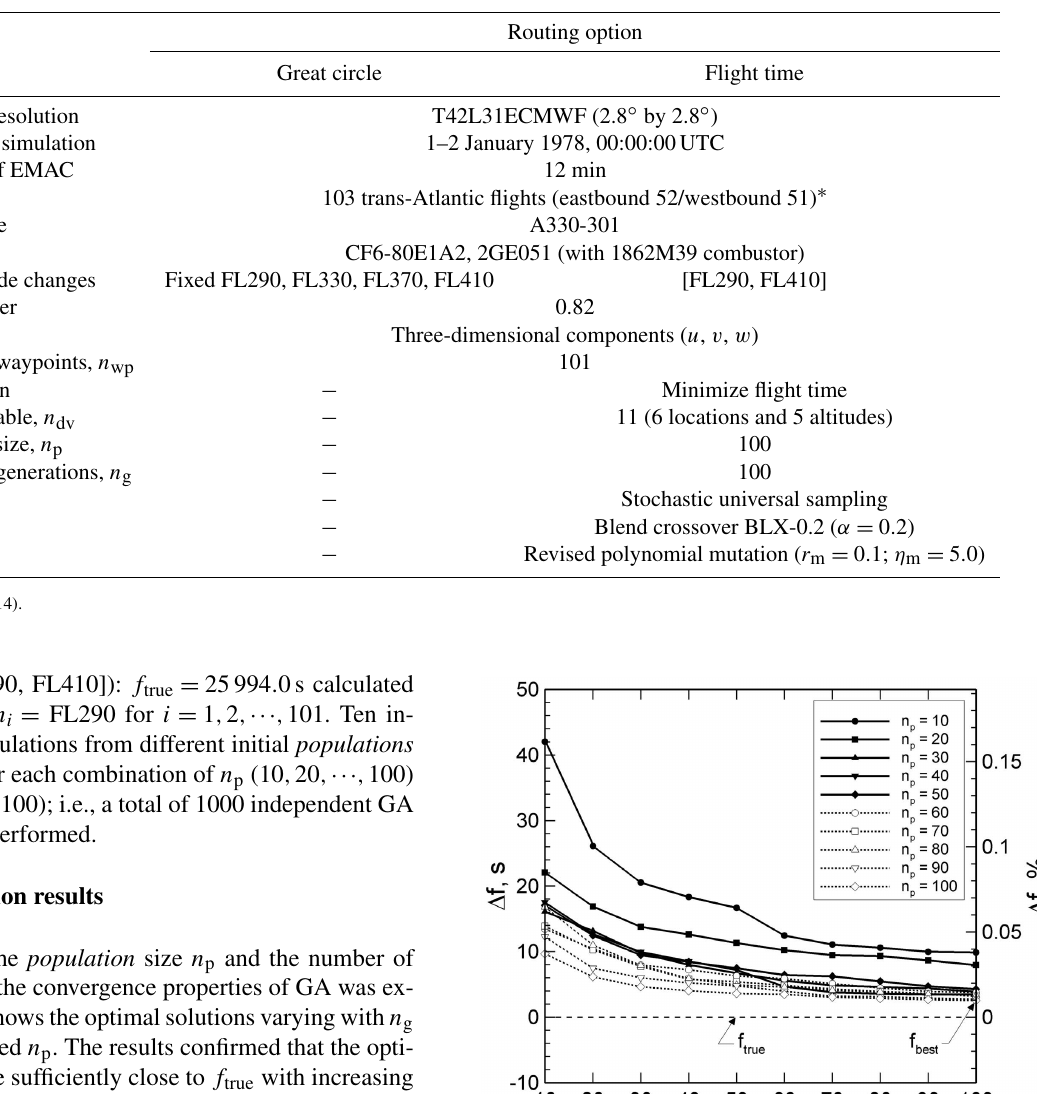
Table 7. Setup for AirTraf 1-day simulations.